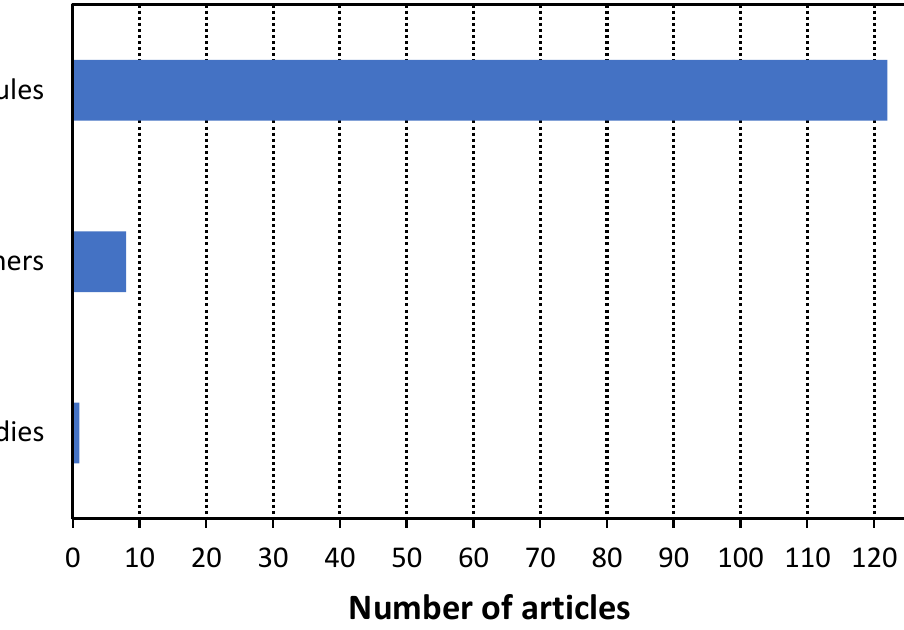
Figure 8. Scientific articles about biosensors and biorecognition engineering technologies for cancer diagnosis published from 2000 to 2021 from Web of Science (up to 10 December 2021).